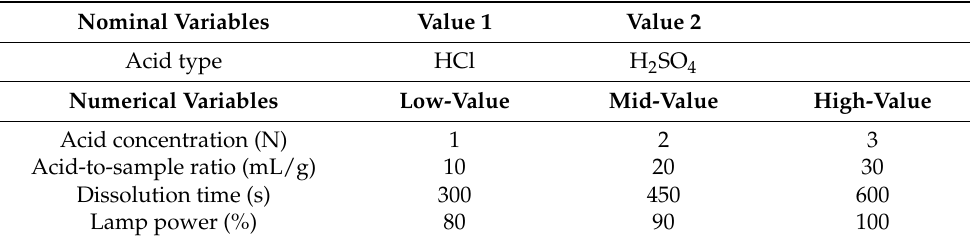
Table 4. Values used during DOE optimization process of the focused infrared digestion of ground magnets.